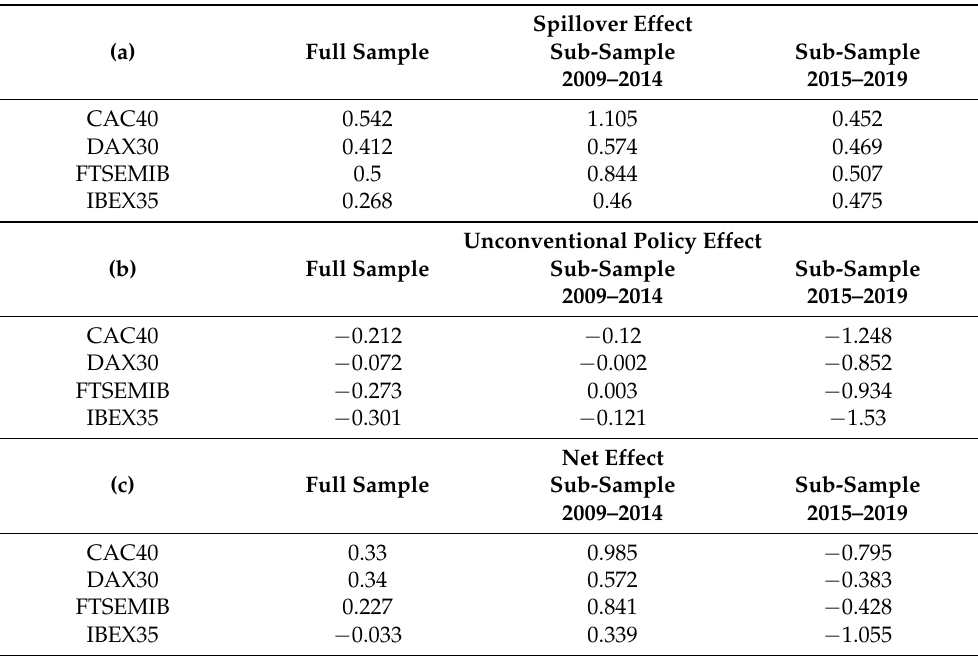
Table 5. ( a ) Spillover effect ( ρ s effect ( a , b ) from the